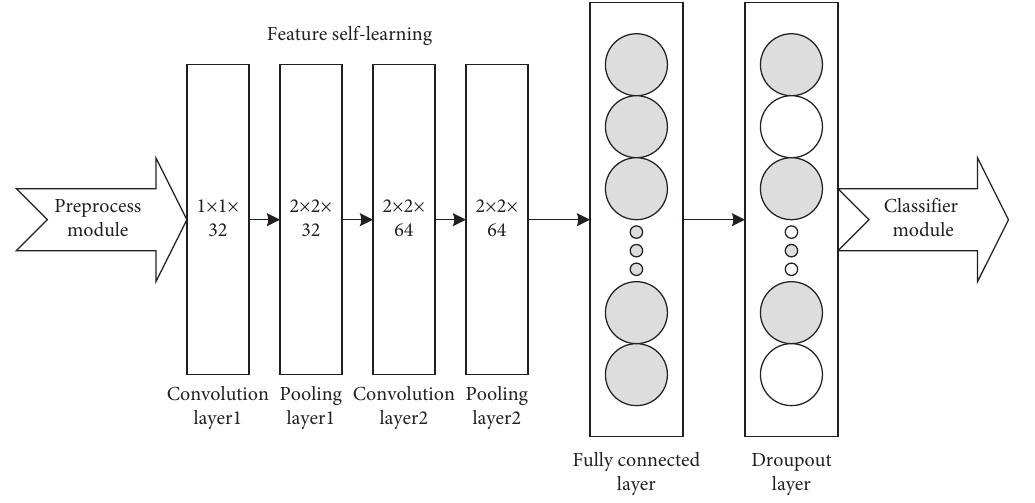
Figure 6: Feature self-learning module. Table 2: KDD-CUP 99 data